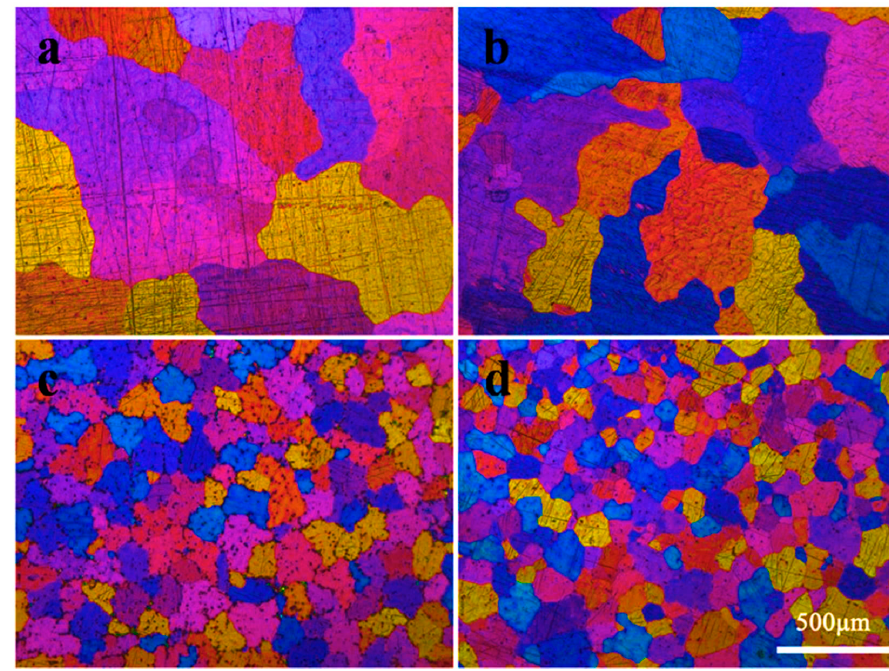
Figure 3. Optical microstructures of the AM50 alloys with ( a ) 0 wt. % B, ( b ) 0.05 wt. %B, ( c ) 0.1 wt. %B, ( d ) 0.15 wt. % B.3.3. Tensile Properties of AM50 + xB Alloys.